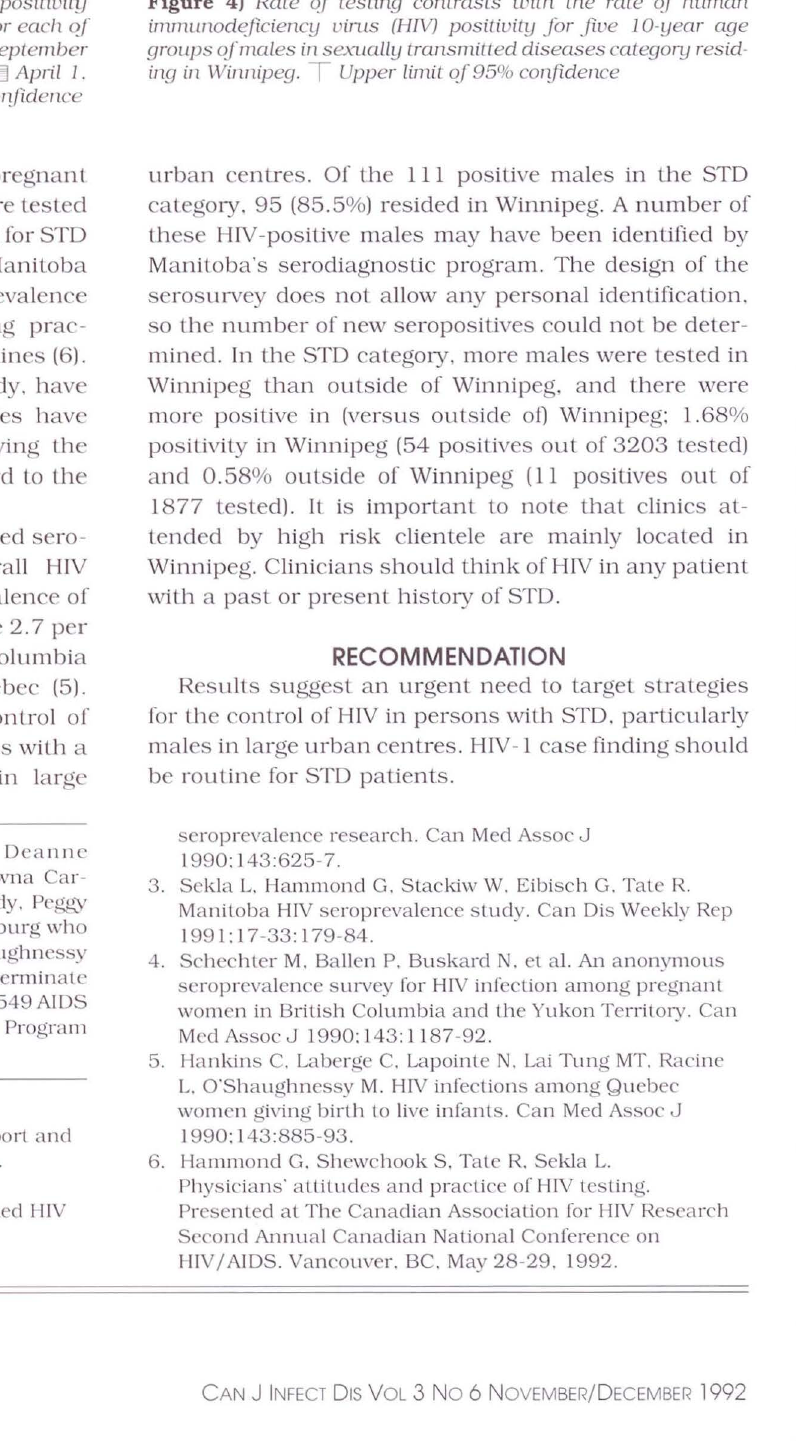
Figure 3) Race of human immw10df!ficiency virus (HIV] posilivily for males and females for each enrollment category for each q{ the study ·s si.x:-month periods. -